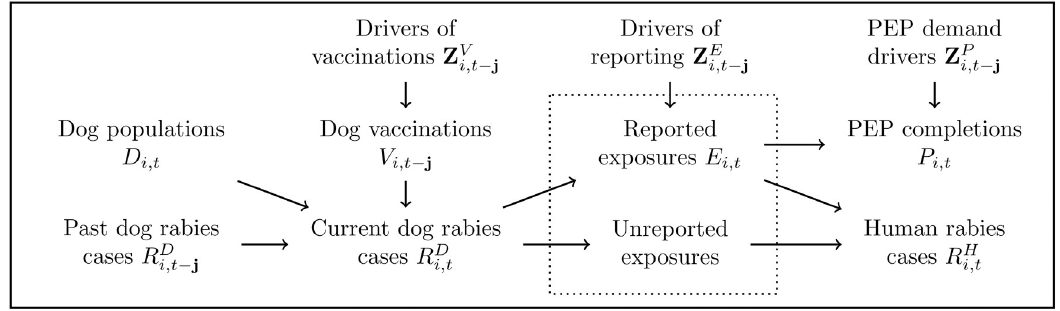
Fig 1. Visual relationship among system